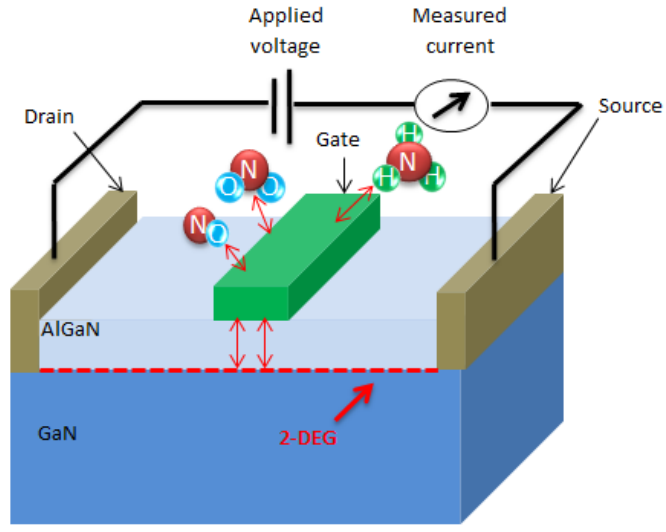
Figure 1. Detection mechanism of the AlGaN/GaN high electron mobility transistors (HEMT)-based gas